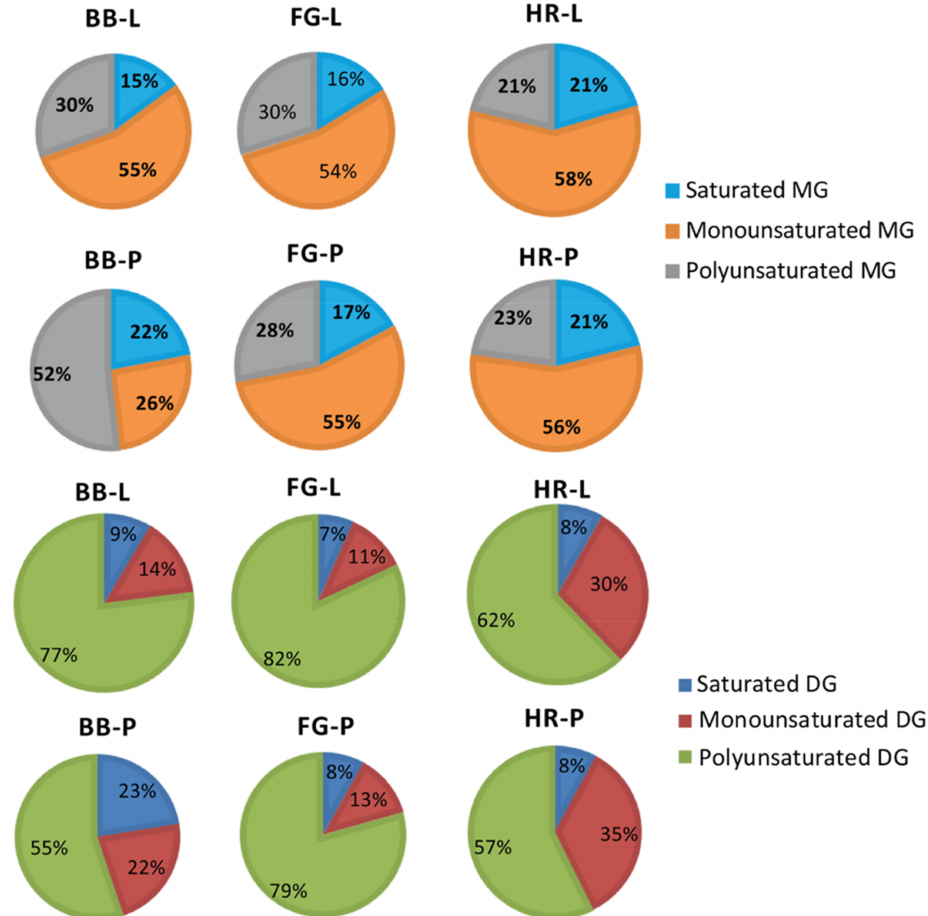
Figure 7. Compositional change of unsaponified monoacylglycerols (MGs) and diacylglycerols (DGs) in natural herbal soaps infused with wild berry extracts. Natural soap acronyms: BB = base bar, FG = forest grove, HR = hibiscus rosehip, L = blueberry, P = partridge